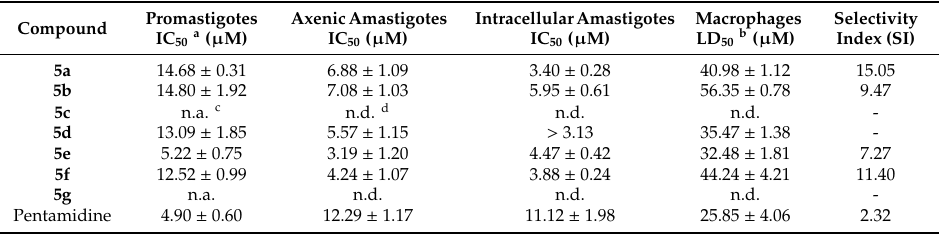
Table 1. In vitro anti-leishmanial activity of chalcone-thiosemicarbazones against promastigotes, axenic amastigotes, and intracellular amastigotes of L. amazonensis after 48 h of culture, and their macrophage cytotoxicity and selectivity index. Compound